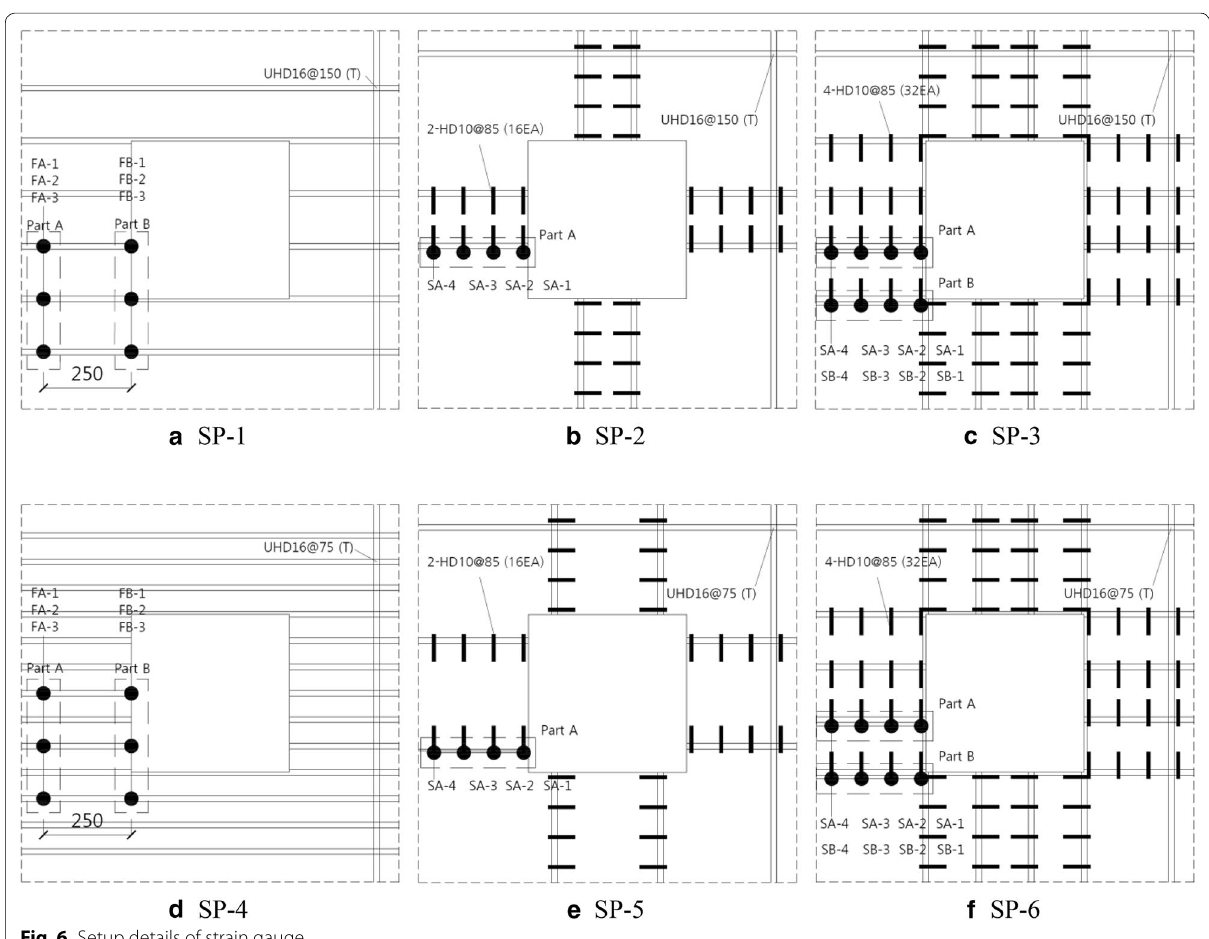
Fig. 6 Setup details of strain